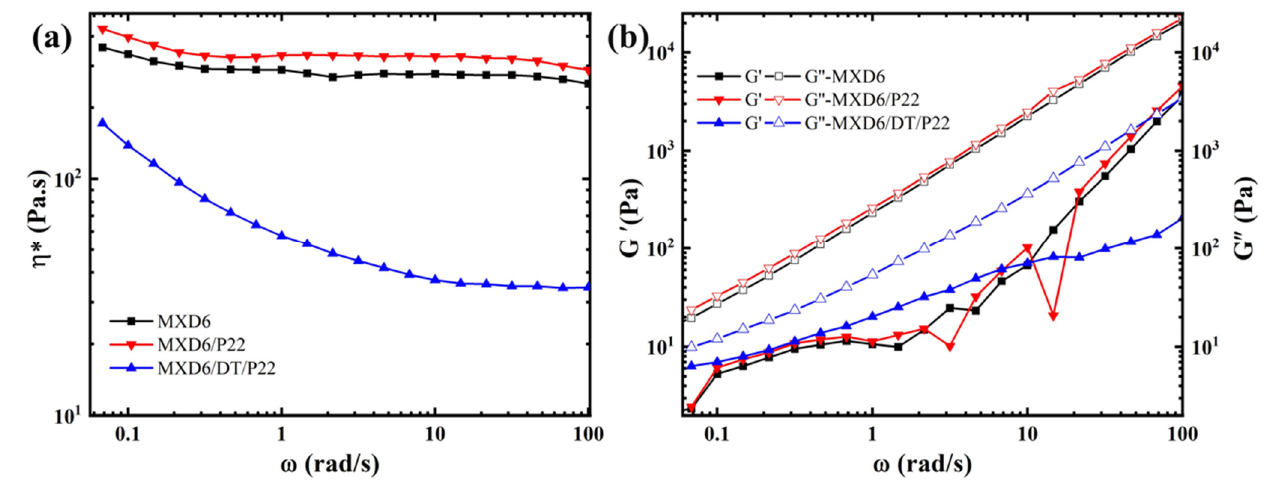
Figure 8. ( a ) Complex viscosity ( η *), ( b ) storage modulus (G (cid:48) ) and loss modulus (G (cid:48)(cid:48) ) vs. frequency of neat and modified MXD6 at 250 °C. Table 6. The mechanical properties of neat and modified MXD6.